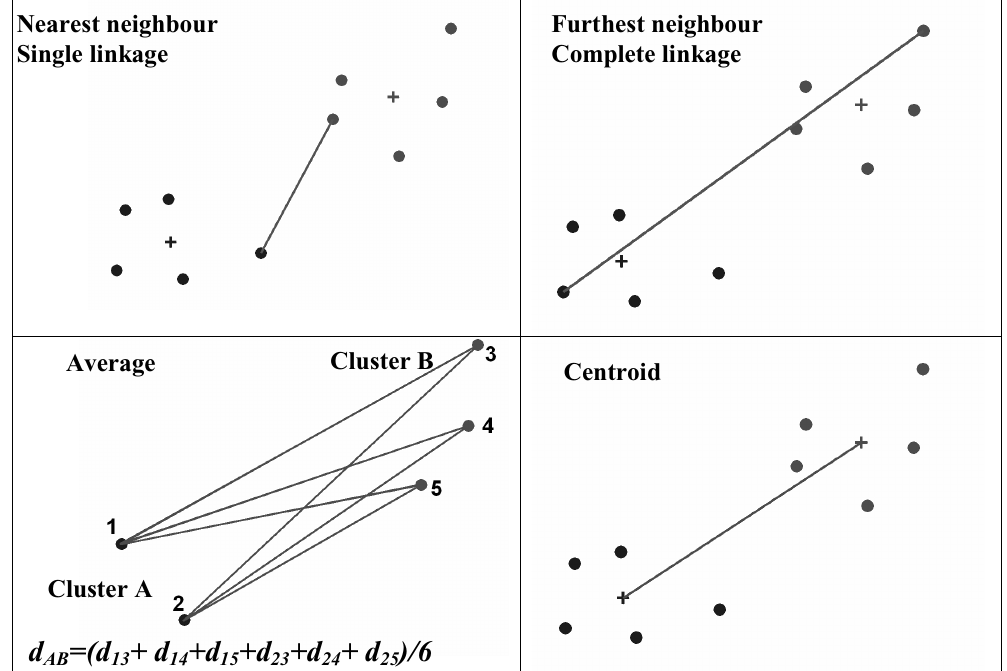
Fig. 1. Different clustering schemes (The + signs mark the centres of the two clusters).